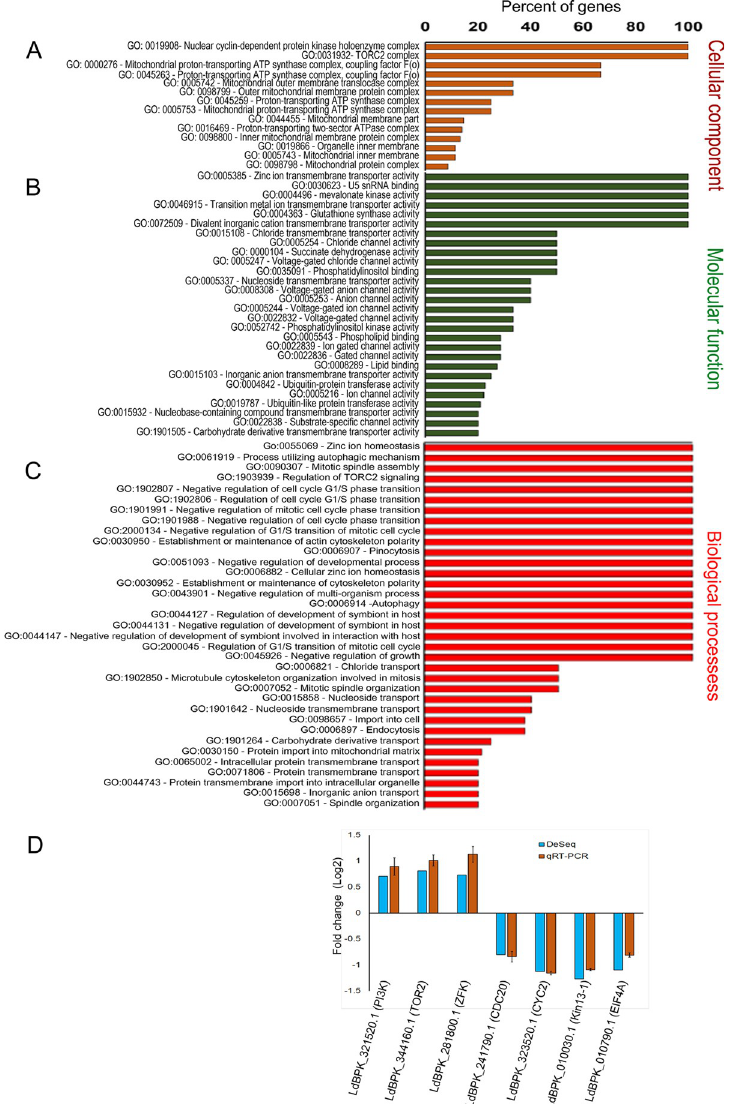
Fig 3. Gene Ontology annotation for all differentially expressed genes and their validation by RT-qPCR. The vertical axis represents the Gene Ontology (GO) categories, and the horizontal axis represents the percentage of significant genes in that particular GO category. (A) The GO annotations of cellular component; (B) The GO annotations of molecular function; (C) The GO annotations of biological processes. The GO terms of p-value < 0.05 were considered; (D) Comparative analysis of the relative expression levels of selected transcripts determined by RNA-Seq and by RT-qPCR. The transcripts corresponding to the genes of interest LdBPK_321520.1.1 (phosphatidylinositol 3-related kinase, putative), LdBPK_344160.1.1 (Phosphatidylinositol 3-kinase tor2), LdBPK_281800.1.1 (differentiation inhibitory kinase, putative), LdBPK_241790.1.1 (cell division cycle protein 20), LdBPK_323520.1.1 (CYC2-like cyclin, putative), LdBPK_010030.1.1 (Kinesin-13-1, putative), LdBPK_010790.1.1 (Eukaryotic initiation factor 4A-1) were validated by RT-qPCR. The RT-qPCR experiments were conducted at least three times and the results were expressed as mean ±